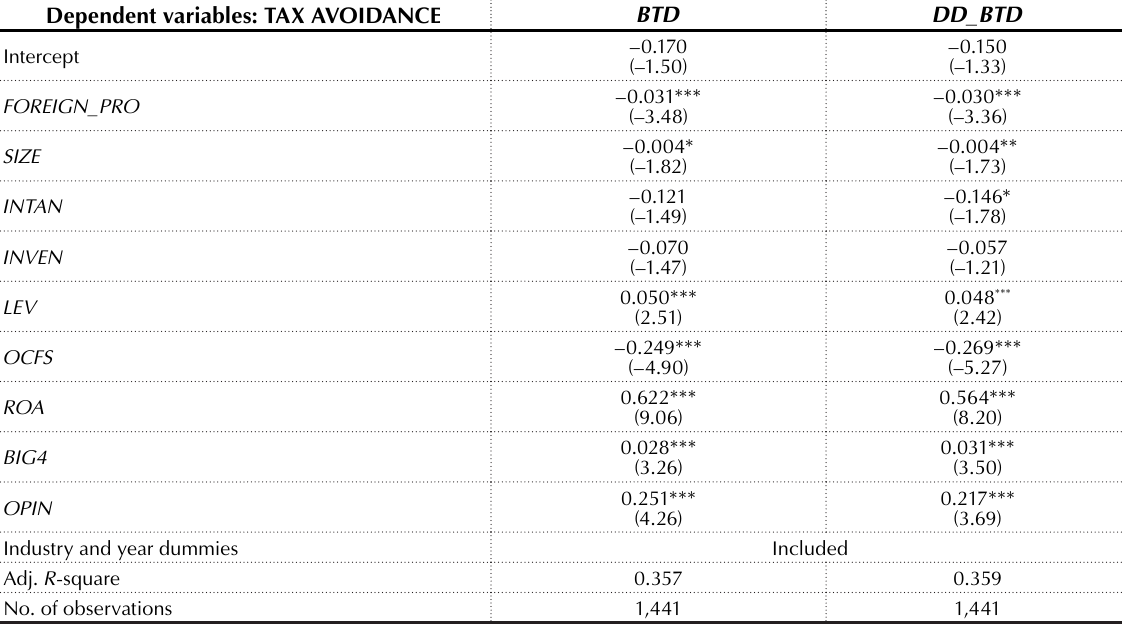
Table 9. The effect of foreign directors with expertise in accounting or finance on